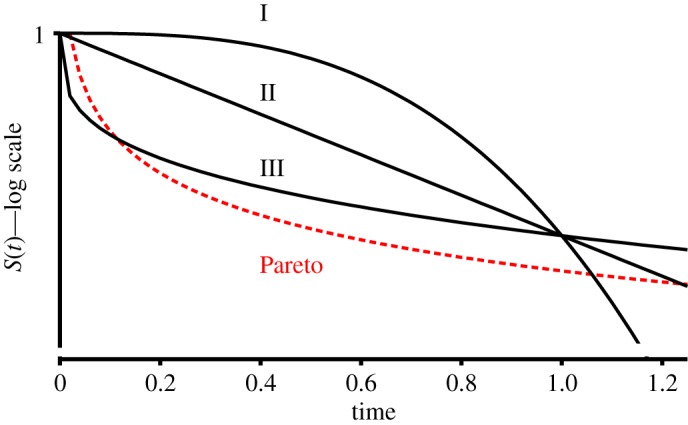
Survivorship curves I, II and III plotted using the Weibull distribution, k = 3, 1, 0.3, visually descending. As in ecological practice, S(t) is on a log scale, allowing the per capita survivorship rates of those still alive, and how this may be changing over time, to be visually inferred from the slope. The Pareto distribution—see text—is plotted for tmin = 0.02, k = 0.3.